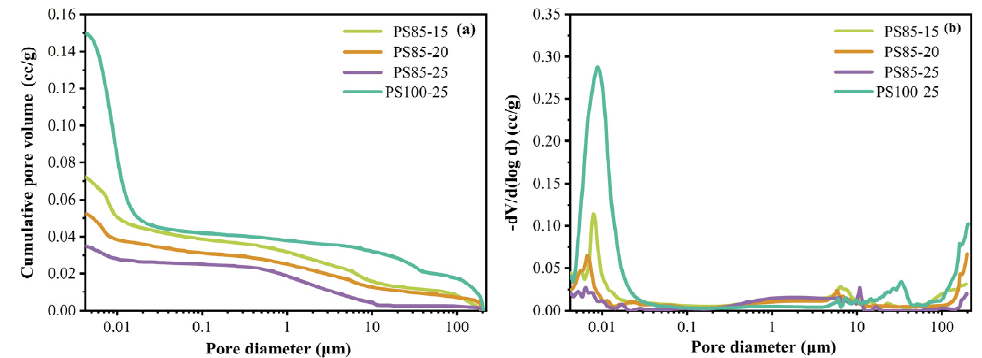
Figure 10. Pore size distribution of WUFA-PS and PS-based geopolymers at 28 days: ( a ) cumulative curves and ( b ) differential curves.